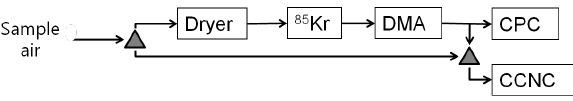
Figure 2. Configuration of instruments for measuring N CCN and characterizing S c during Gosan 2008 and BCMO 2009. The grey triangles represent 3-way valves. Fig. 2. Configuration of instruments for measuring N CCN and char- acterizing S c during Gosan 2008 and BCMO 2009. The grey trian- gles represent 3-way